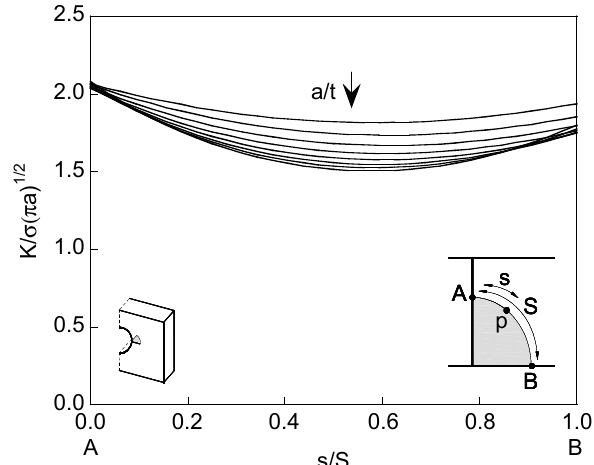
Figure 10. Dimensionless stress intensity factor (SIF) along the crack front for the preferential fatigue propagation path (fatigue in air; cracks emanating from a plate corner).